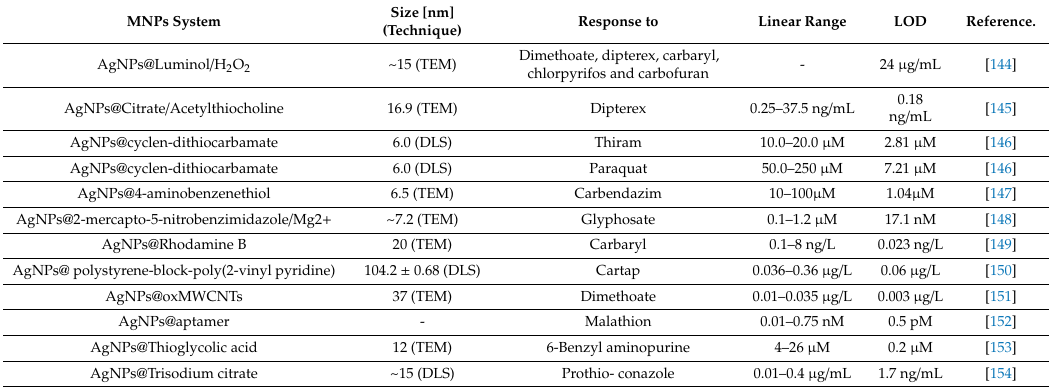
Table 3. List of AgNPs systems as optical sensors for pesticides detection: size and sensing